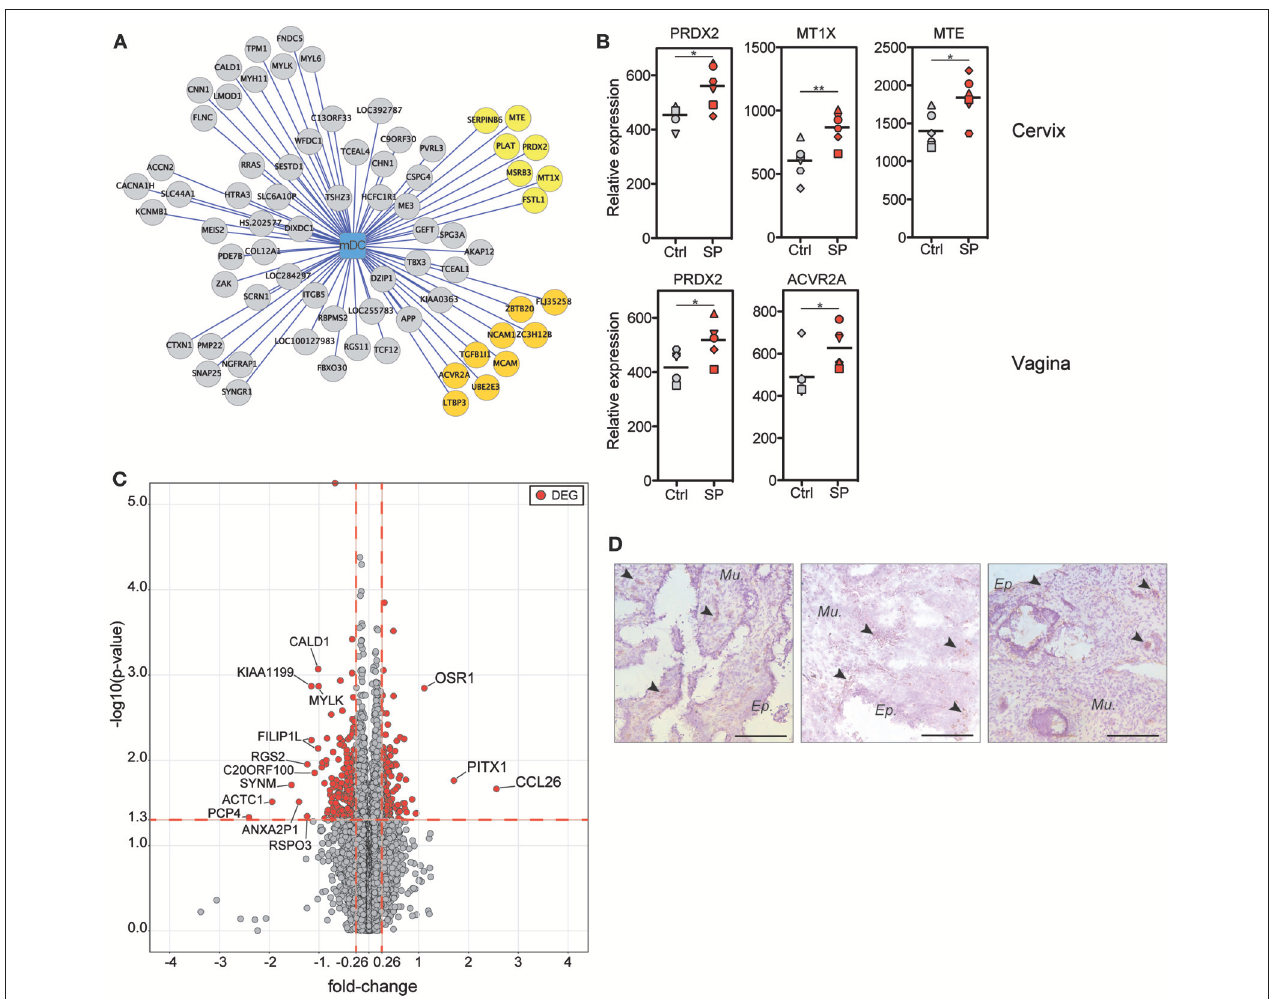
FIGURE 5 | Upregulation of inflammation-related gene expression is associated with mDC recruitment after SP exposures. (A) Graph showing the correlations between the mDC abundance and DEG expression in the FRT (vagina, cervix, and uterus). Each node of the graph corresponds to a biological variable and links between the nodes correspond to significant positive correlations (Spearman correlation coefficient). Genes are represented by circles and the mDC cell population by the square. Gene circles colored in yellow are known to be involved in immune-related process. (B) Relative expression of inflammation-related genes identified in (A) that are upregulated by SP exposures. Each symbol represents one animal from control (gray) or SP group (red). The Mann-Whitney test (*) was used to compare gene expression between the two groups (* p < 0.05). (C) Volcano plots showing fold-change (FC, x axis) and statistical significance distribution (–log( p -value), y axis) for DEG between to PBS or SP exposure in the cervix. (D) Location of CCL26-producing cells in cervical tissue sections from SP exposed animals ( n = 3). Black arrows indicate brown CCL26 + cells and the black bar indicates 100 µ